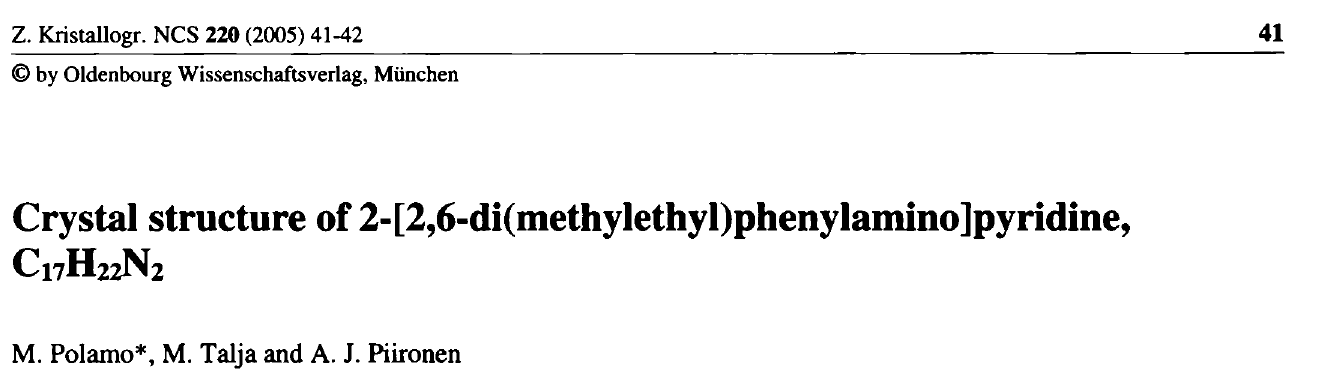
Table 1. Data collection and handling. Crystal: Wavelength: M- Difiractometer, scan mode: 20ΤΏΛΧ- Nthkllmsani. N(hklhm Criterion for /<*», N(hkl)gi: N(paramhrBoeA· Programs: